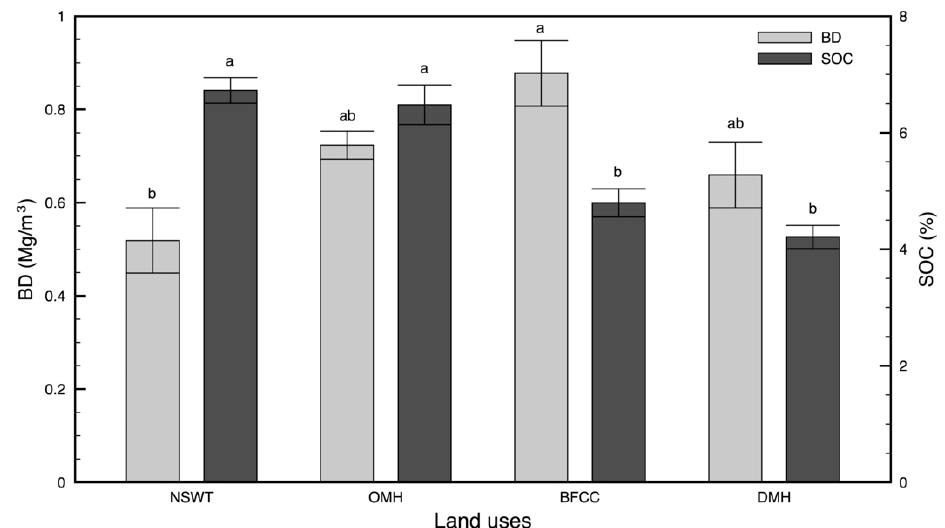
Figure 2. Bulk density (BD) and soil organic carbon (SOC) concentration at a 0–30 cm depth, in the four dominant land uses at Santuario de Fauna y Flora Iguaque , Boyacá, Colombia. NSWT: natural grasslands prevailingly without trees and shrubs; OMH: open heathlands and moorlands; BFCC: broad ‐ leaved forests with continuous canopy, not on mire; DMH: dense heathlands and moorlands. Error bars correspond to standard error. Different letters indicate statistical differences ( p < 0.05).